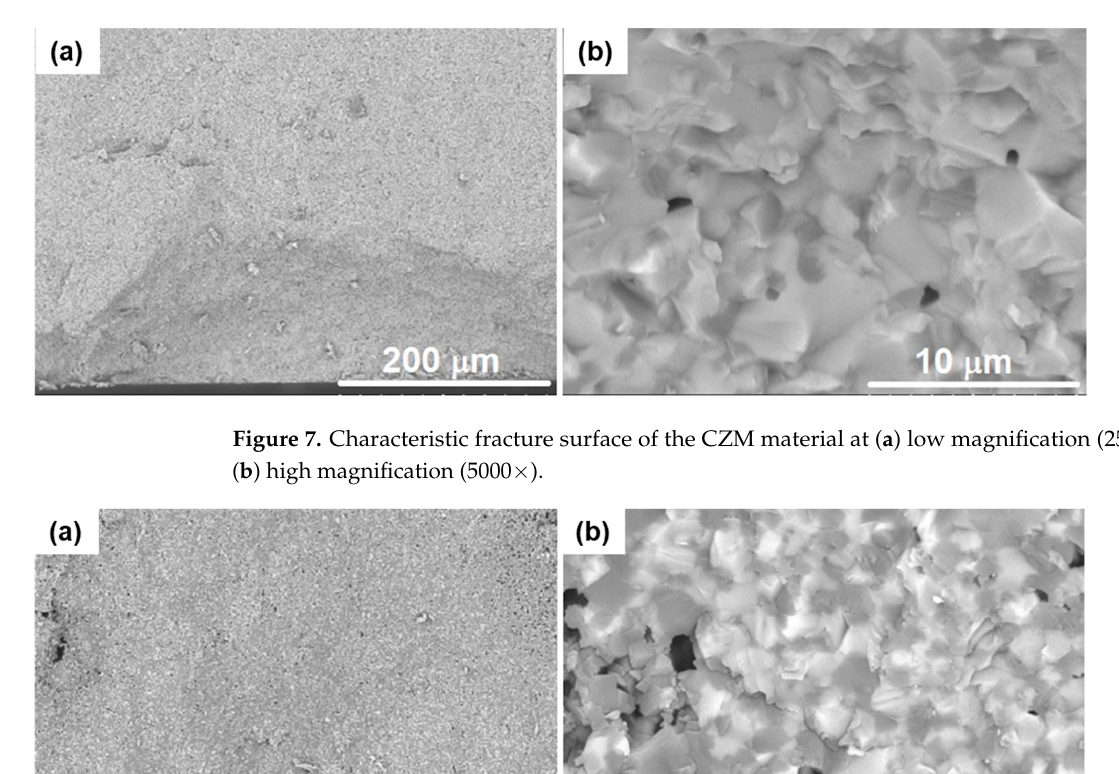
high magnification (5000×).